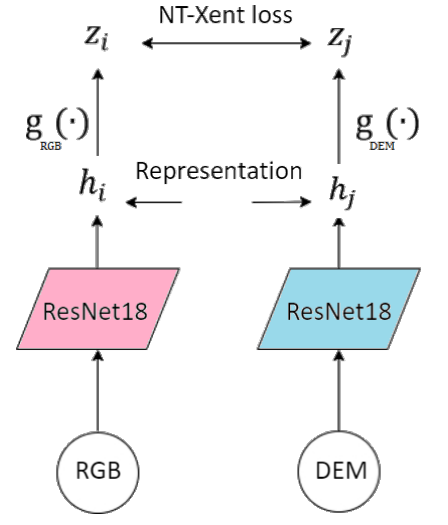
Figure 2. Proposed contrastive learning framework for VPR.